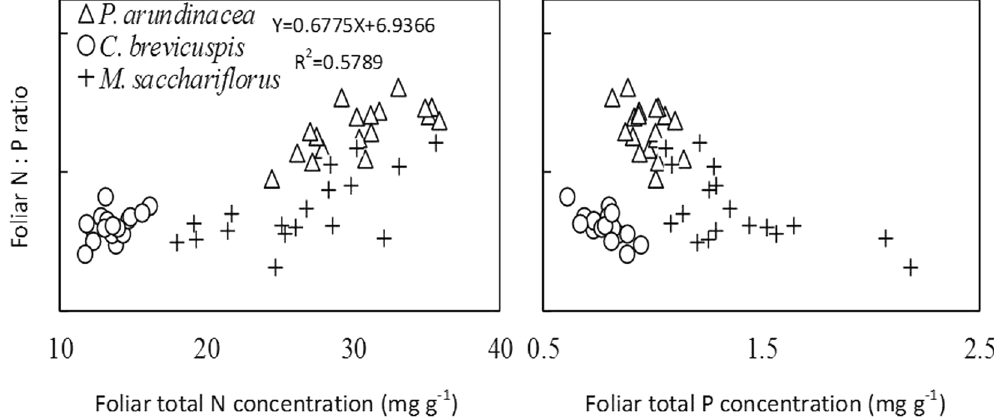
Figure 3. Relationship of foliar N:P with foliar total nitrogen (N) and total phosphorus (P) concentrations of the 3 wetland species distributed along an elevation gradient in 3 lakeshore areas of Dongting Lake, China.